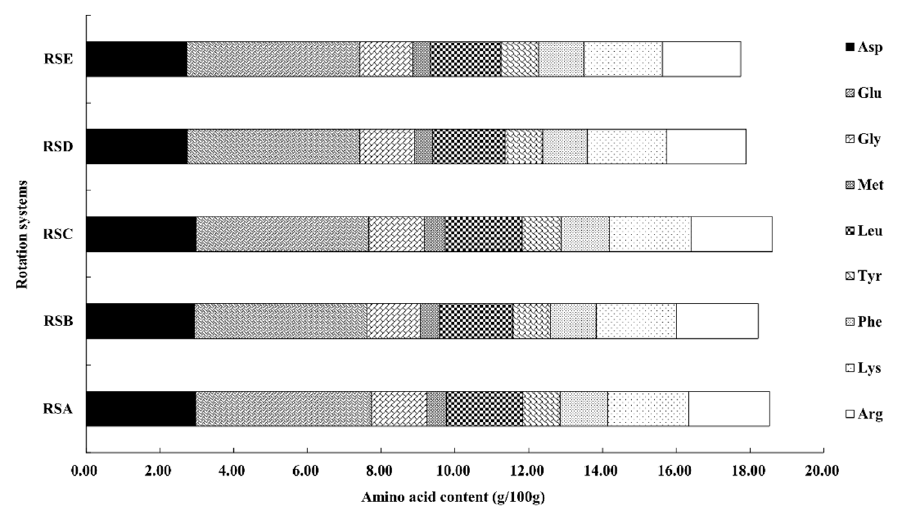
Figure 5. Medicinal amino acid composition of M. importuna under different rotation systems, including: asparaginic acid (Asp), glutamic acid (Glu), Glycine (Gly), methionine (Met), leucine (Leu), tyrosine (Tyr), phenylalanine (Phe), lysine (Lys), and arginine (Arg).